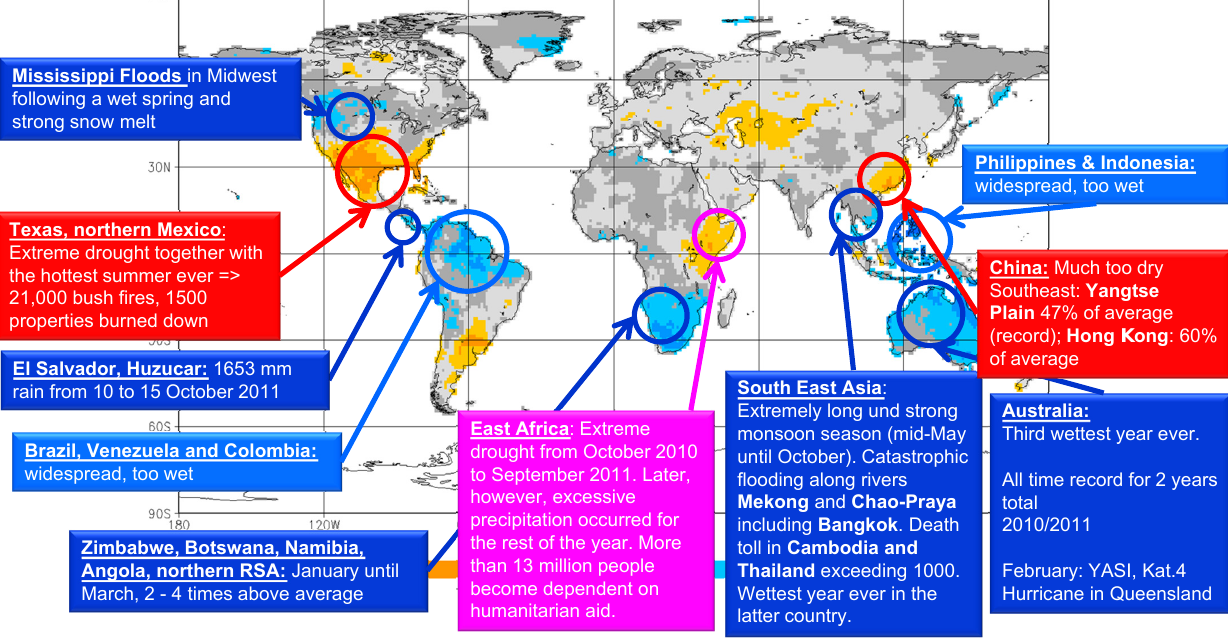
Figure 2. Centennial climatology of ENSO sensitive regions with regard to the global land-surface precipitation from 1901 to 2010. Blue (red) areas have enhanced (reduced) precipitation during La Niña periods. In addition, the circles and boxes point to extreme hydro-meteorological events (including devastating floods) which occurred during the strong La Niña year